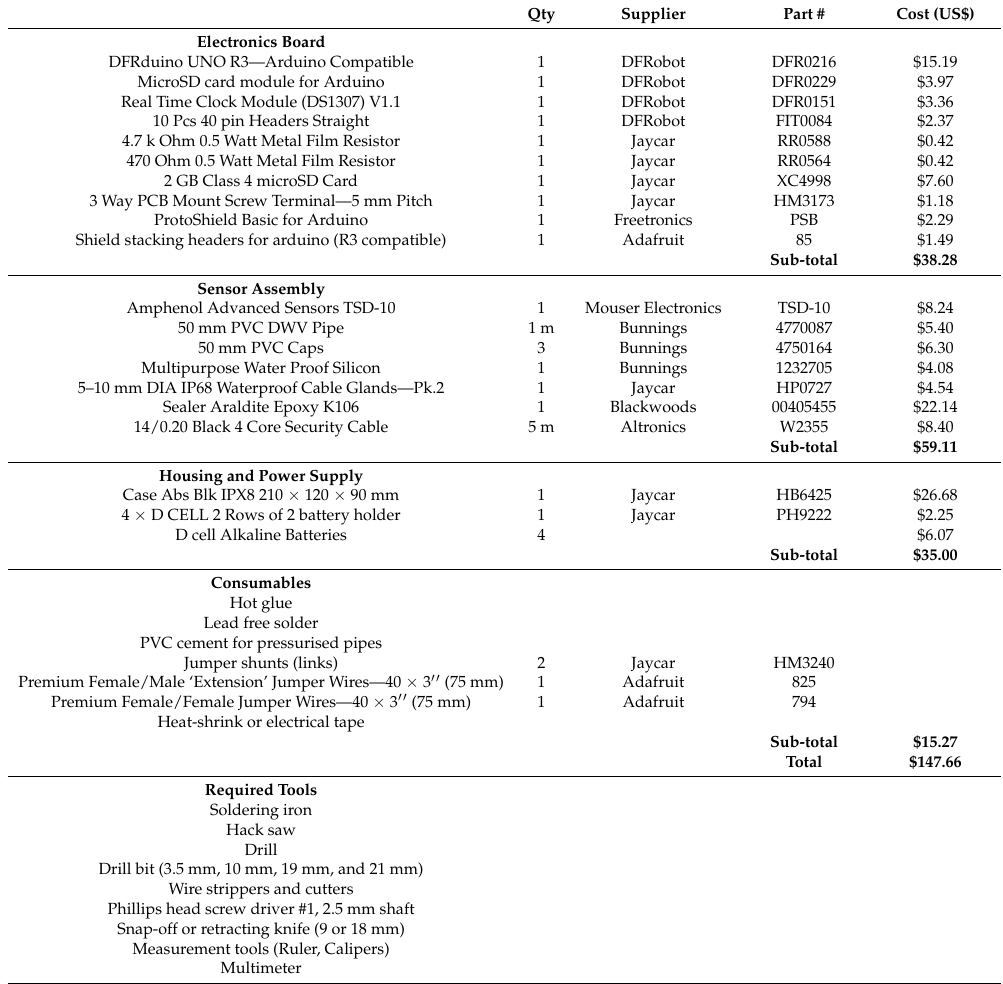
Table A1. A complete list of required parts, consumables, and tools required for the assembly of a low-cost sensor, prices as of November